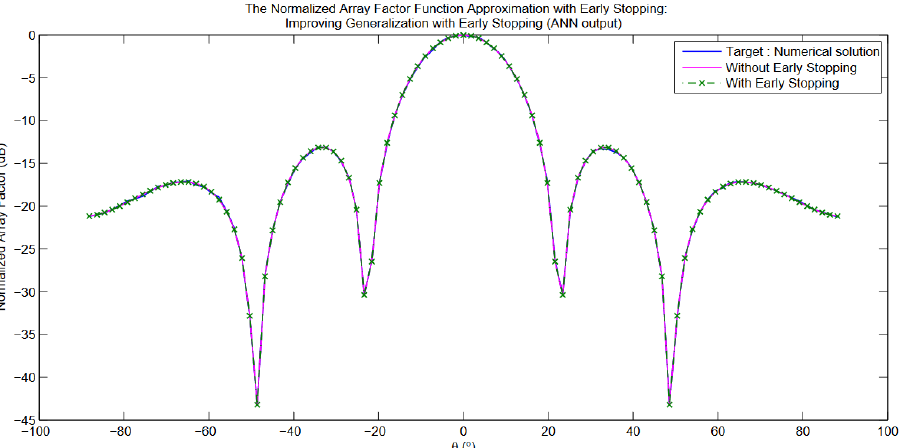
Figure 30. The ANN output as a radiation pattern with early stopping (ES) (improving generalization with early stopping): for (5 × 1) aperiodic phased half-wavelength planar dipoles with (10101) voltage configuration [22].